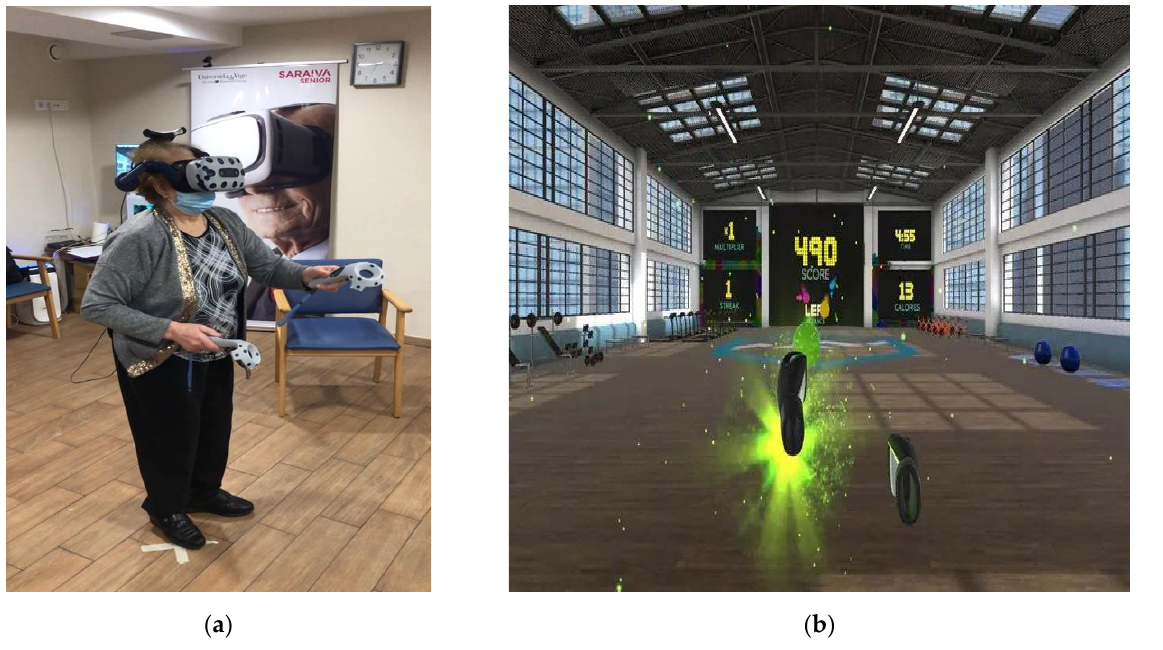
Figure 4. Real gym and virtual gym: ( a ) Participant during an exergame session; ( b ) Screenshot of the exergame proposed (BOXVR).